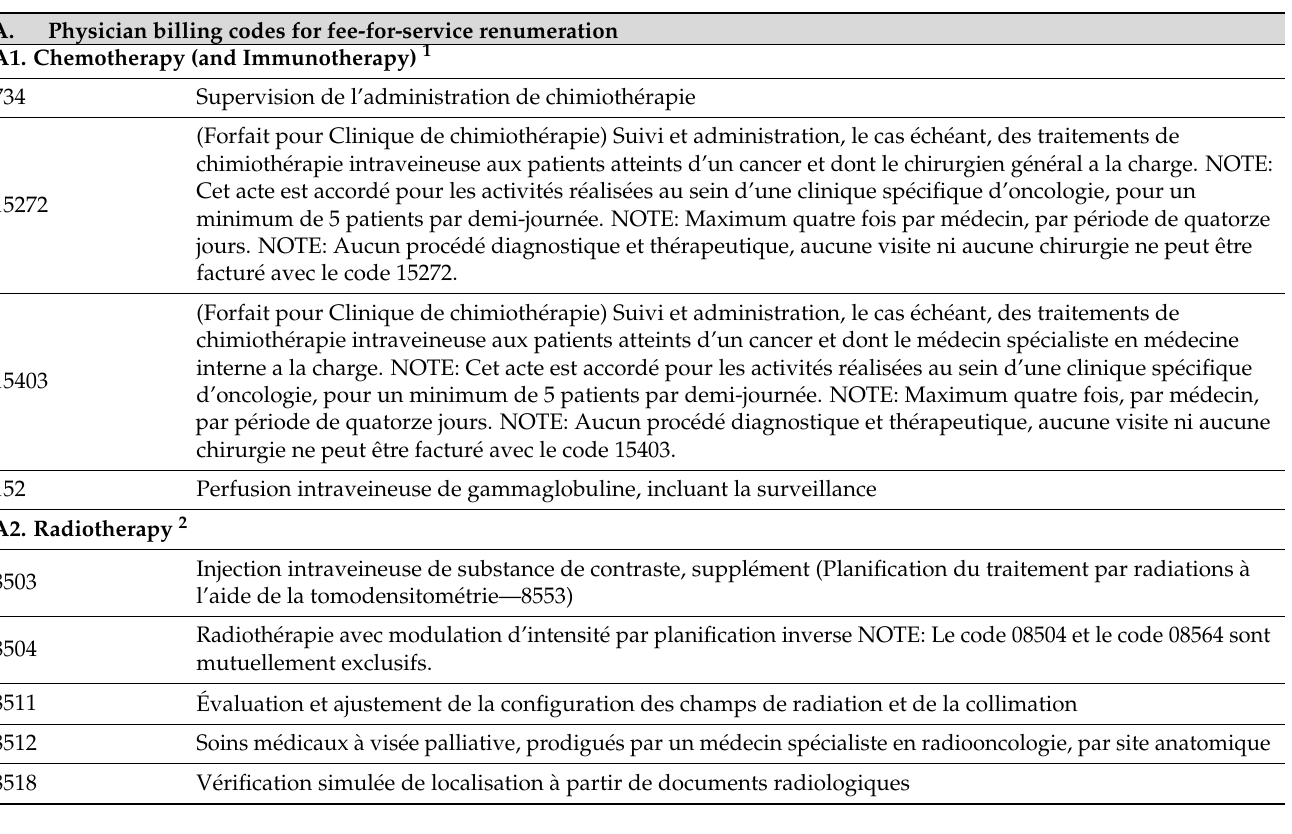
Figure A1. Classification of patients according to the line of treatment with 1st EGFR-TKI. Table A4. Cancer-Related Intervention Codes in SMOD and